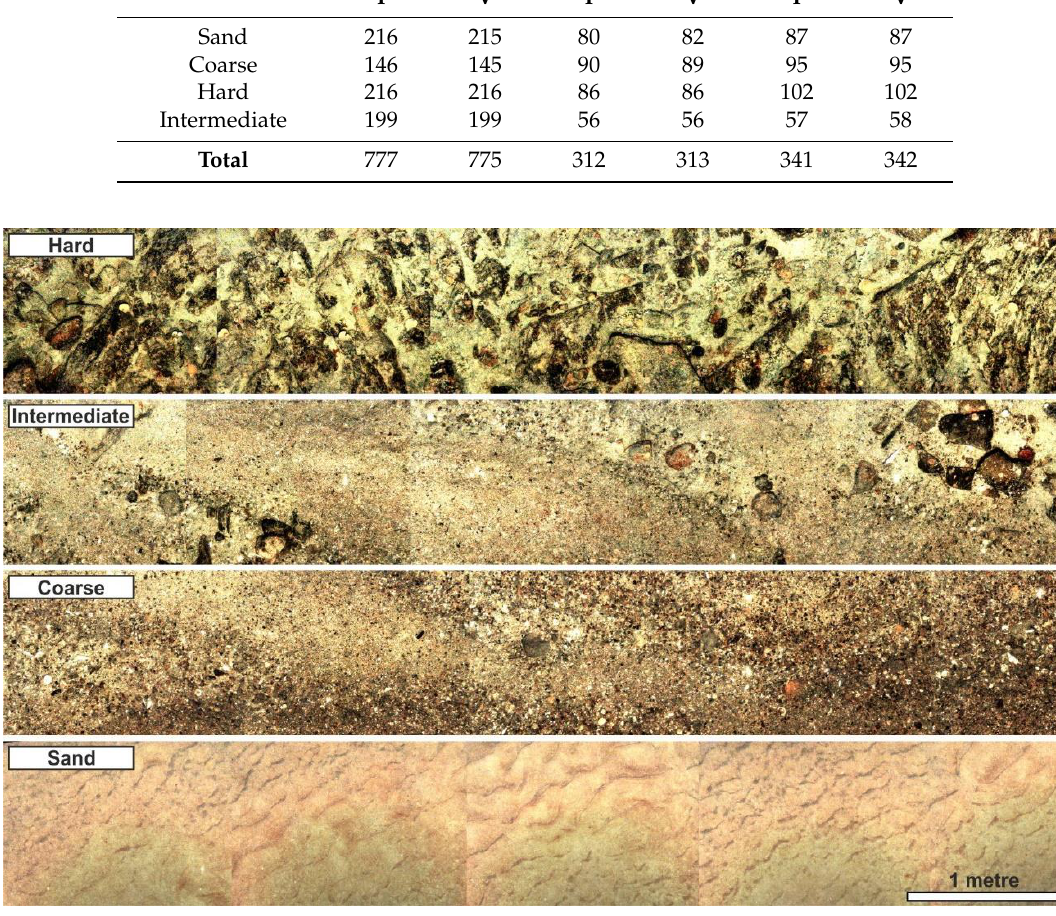
Figure 4. Seabed habitat classes identified in the groundtruth data. Table 3. Groundtruth data, as the number of image tiles (mosaics of five consecutive images) used to groundtruth the sidescan sonar classifications, separated into training (T) and validation (V) sets by year and survey day [28]. Images to groundtruth the 2012 classification were taken in 2012, all images to groundtruth the 2015 classifications were acquired during one AUV mission in 2015.